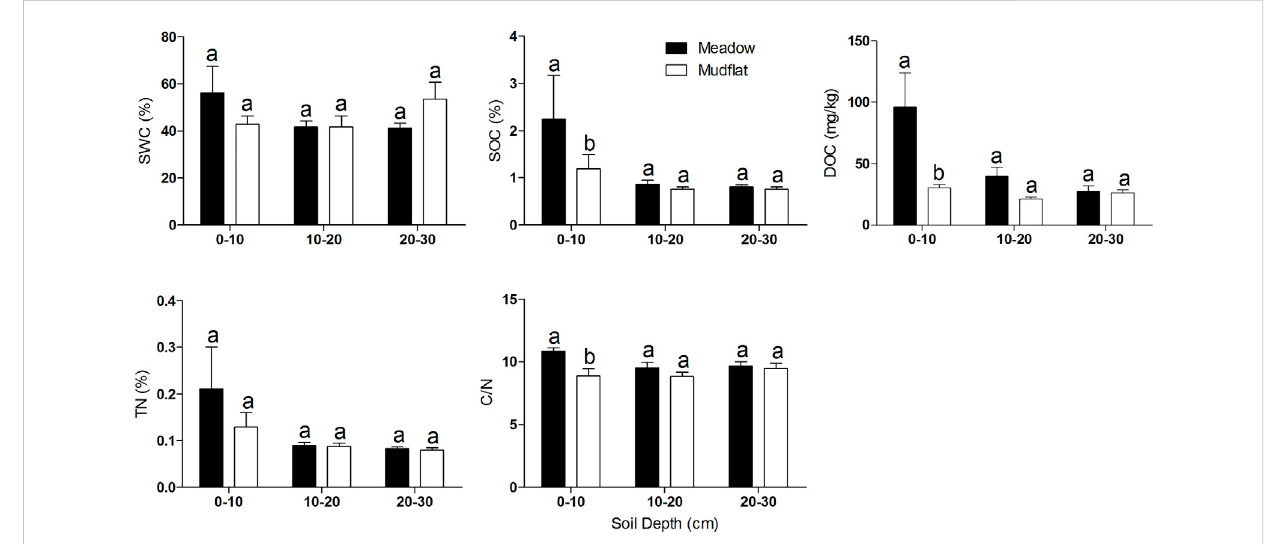
FIGURE 4 The differences of soil properties between meadow and mud fl at. The values of each soil property with the same lowercase letter do not differ signi fi cantly ( p > 0.05) based on the Wilcoxon signed rank test.